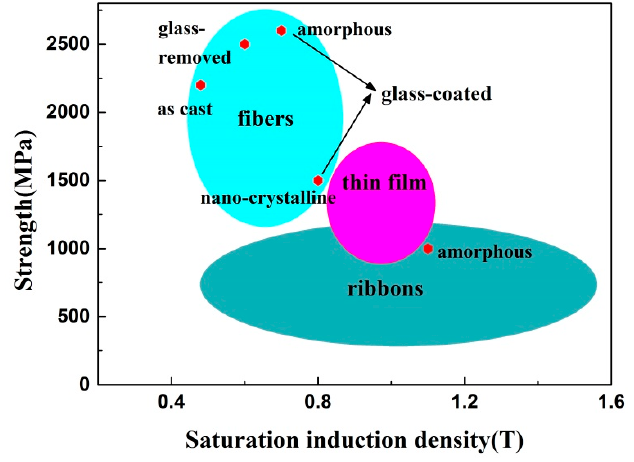
Figure 15. The map of tensile strength and saturated magnetization of the FeCuNbSiB alloy system with different shapes and structures.